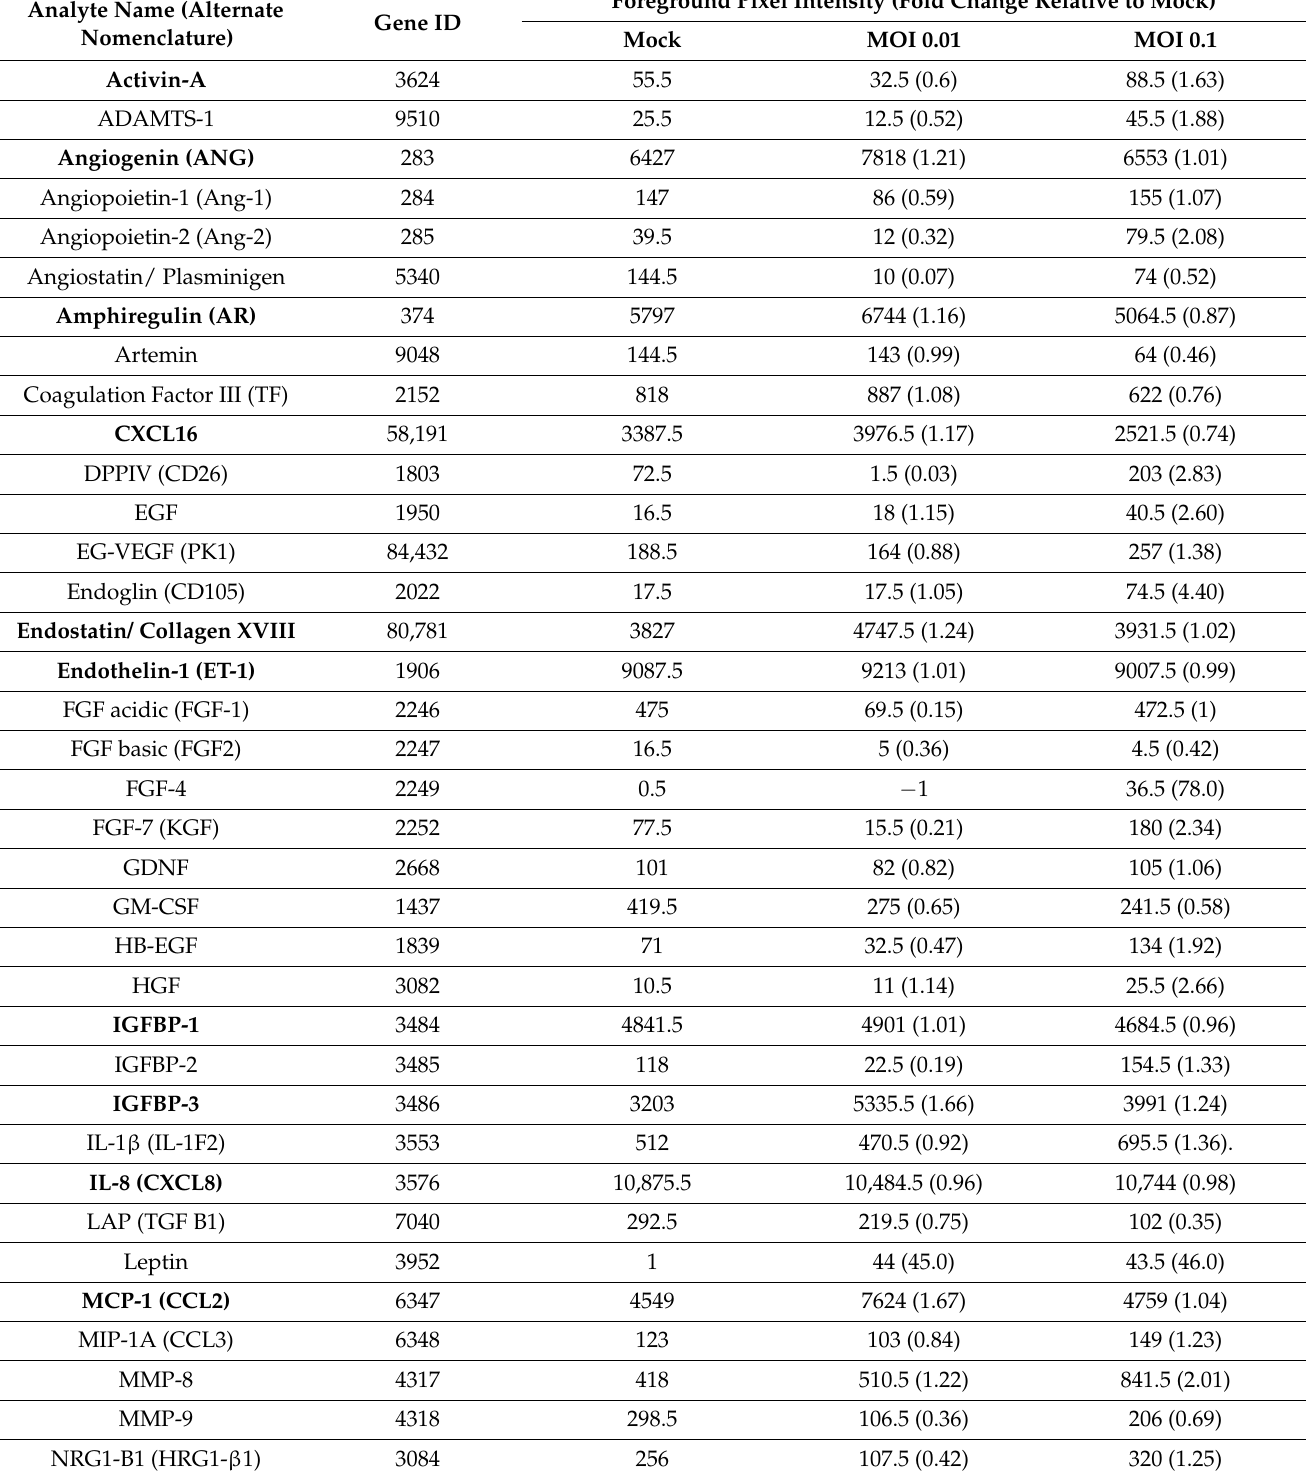
Table 2. Differentially secreted angiogenic proteins in SARS-CoV-2-exposed